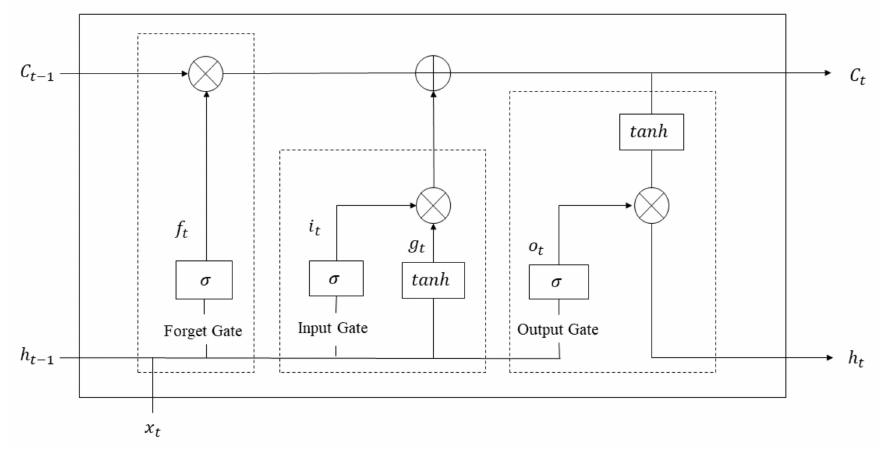
Figure 1. LSTM cell